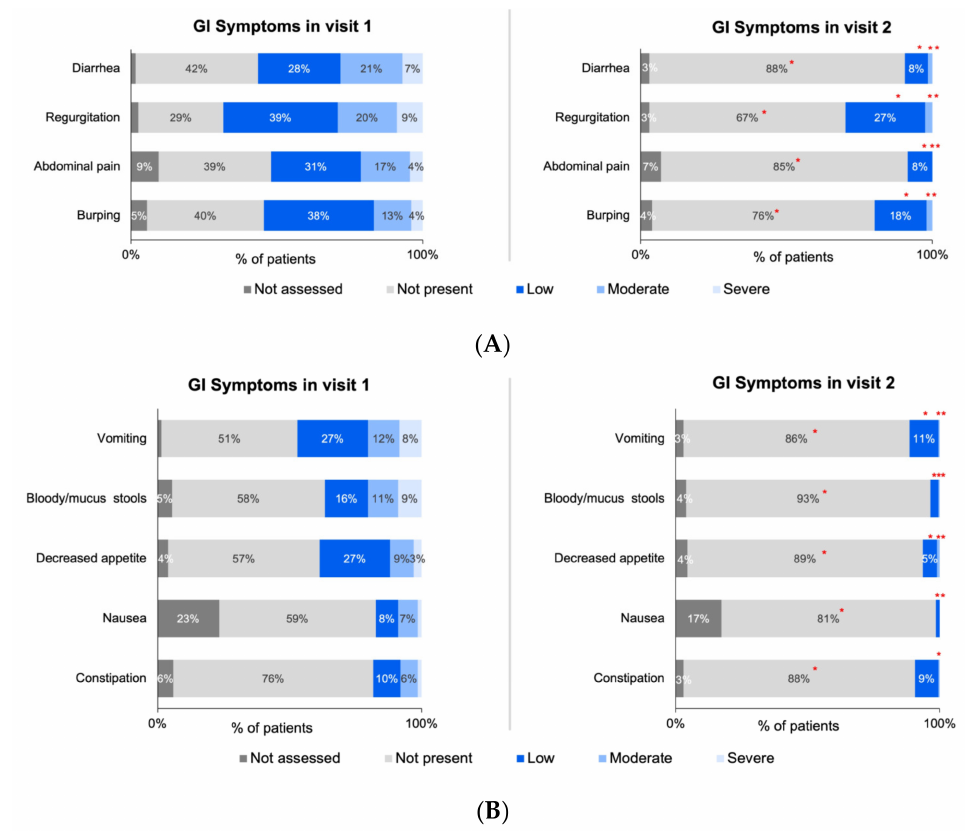
Figure 3. ( A , B ) Distribution of GI symptoms severity across initial and follow-up visits for infants ≤ 6 months of age with suspected or diagnosed CMPA. Note: ‘*’ denotes statistically significant symptom improvement between Visit 1 and Visit 2 (specific p -values listed in Figure S1).